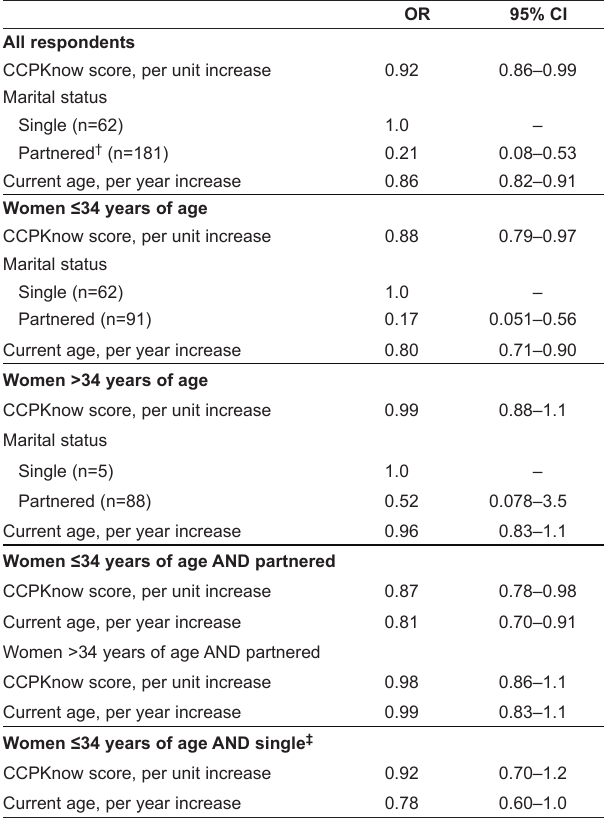
TABLE 4 Multivariable logistic regression model for estimating the effect of infalmmatory bowel disease